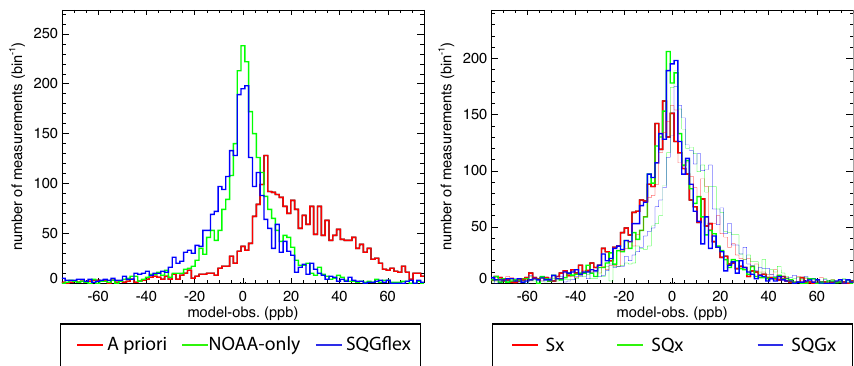
Fig. 7. Frequency distribution of fit residuals between surface measurements and optimized TM5. (Left panel) Red: a priori; green: NOAA inversion; blue: SQG flex . (Right panel) Red: S ; green: SQ; blue: SQG. Bold lines: flex scenarios; thin lines, fix scenarios.